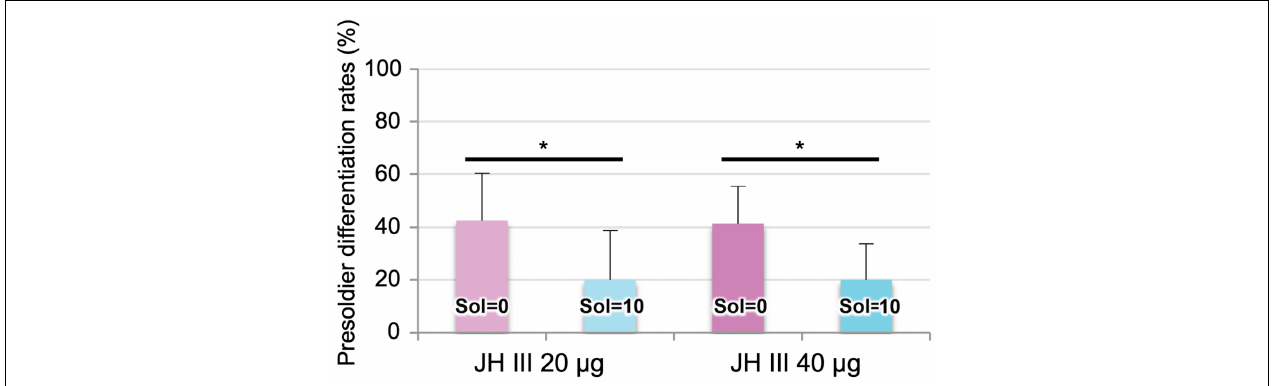
FIGURE 1 | Presoldier induction rates (mean ± S.D., biological quadruplicates) 16 days after the 20 or 40 µ g juvenile hormone (JH) III application in Reticulitermes speratus . In both applications, presoldiers were more frequently differentiated from workers with 0 soldiers (soldier absence, “Sol = 0”) than those with 10 soldiers (soldier presence, “Sol = 10”) (generalized Wilcoxon test, * P < 0.05).